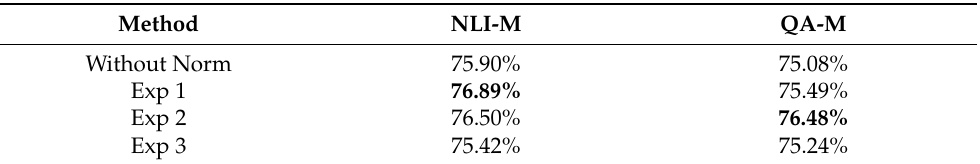
Table 8. Performance results on T4 using NLI-M and QA-M methods for the three experiments. Accuracy metric was